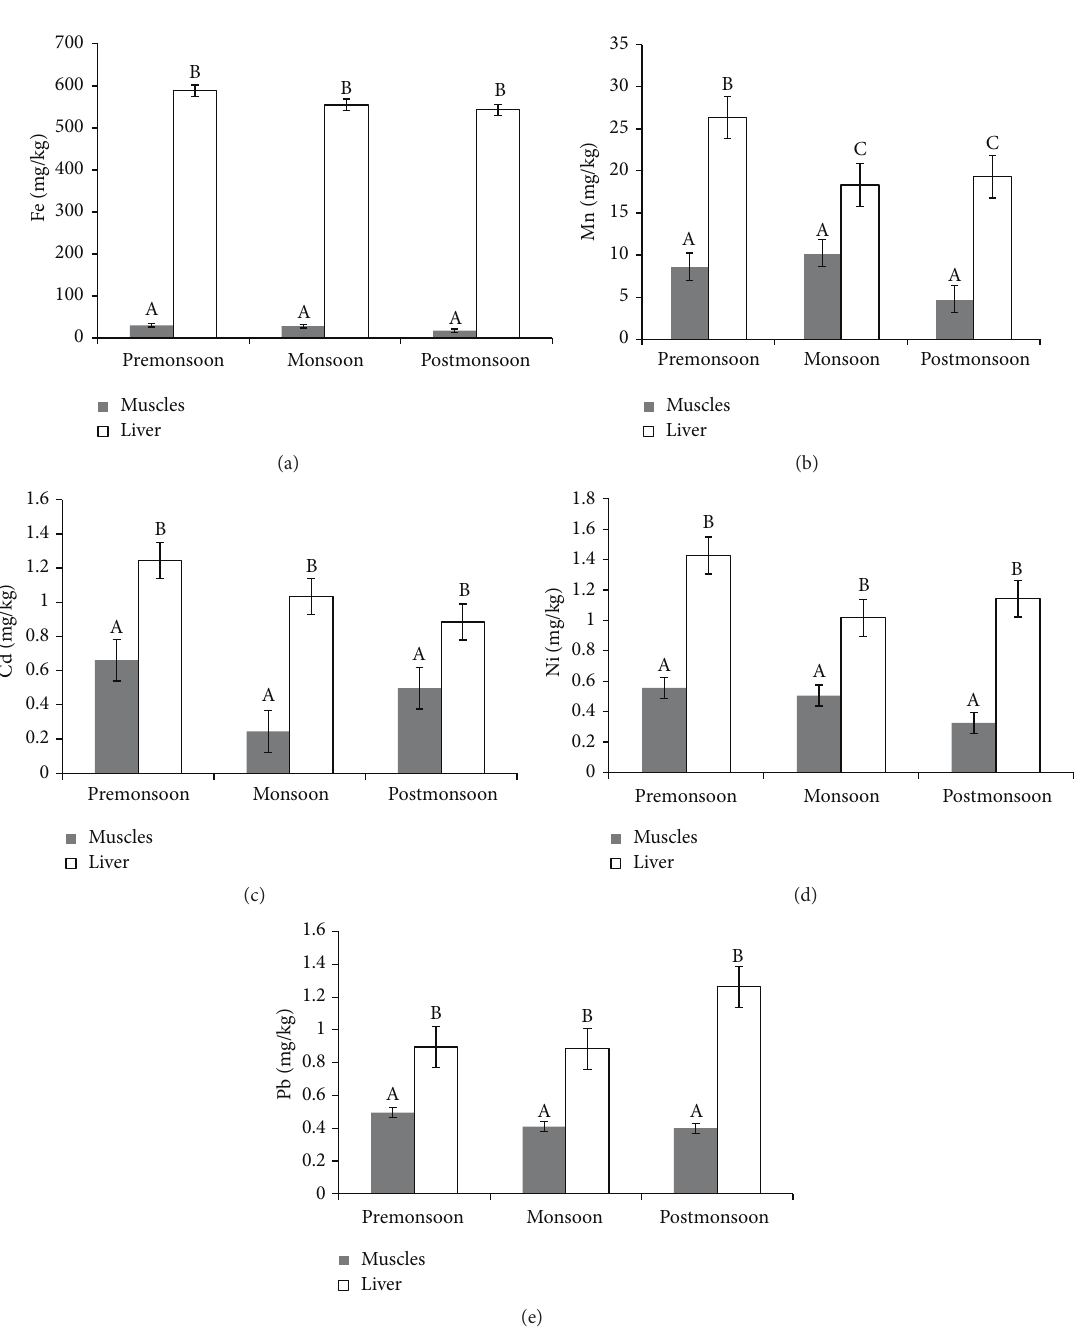
Figure 2: Metal concentration (mean ± SE) in muscles and liver Terapon puta from Karachi Fish Harbor for Fe (a), Mn (b), Cd (c), Ni (d), and Pb (e) during different seasons of January 2012 and December 2012. A, B, and C = the same letters beside the vertical bars in each graph indicate that the values are not significantly different ( 𝑃 > 0.05